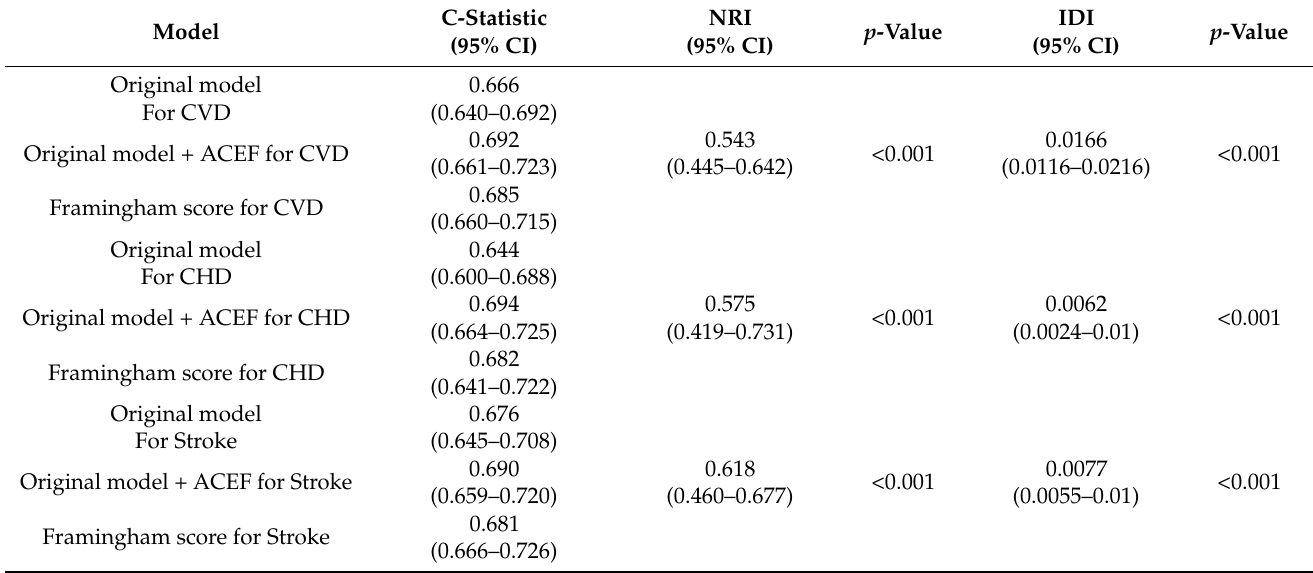
Table 3. Discrimination and reclassification for CVD with the addition of ACEF to traditional risk factors